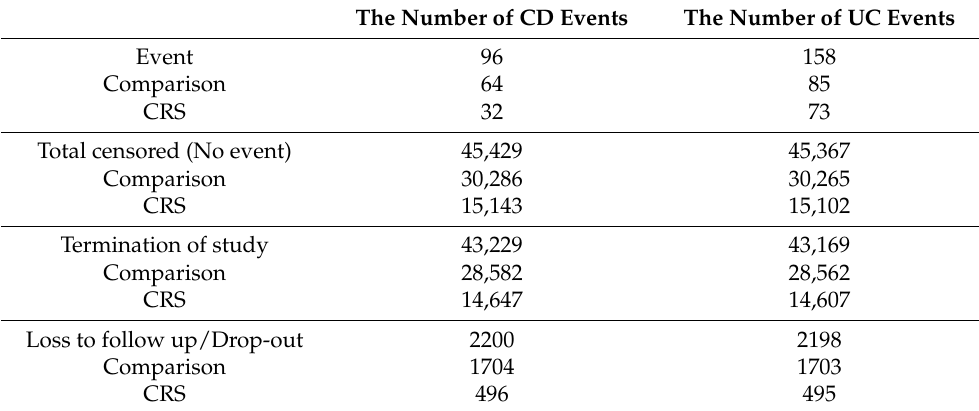
Table 3. Description of time to event and censored